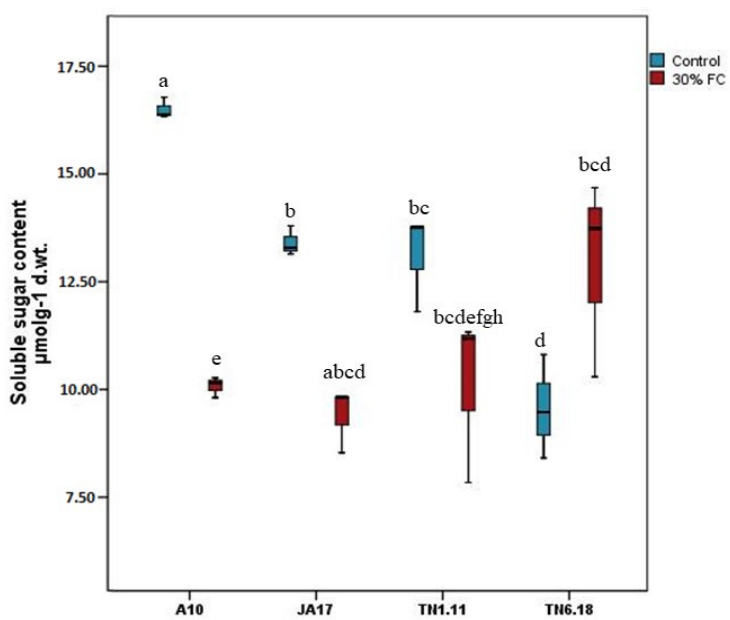
Figure 9. Variation in soluble sugar content for the studied lines of M. truncatula under control treatment and 30% of field capacity. Means followed by the same or a common letter (s) are not significantly different among the studied lines for each trait according to Duncan’s test at 5%.